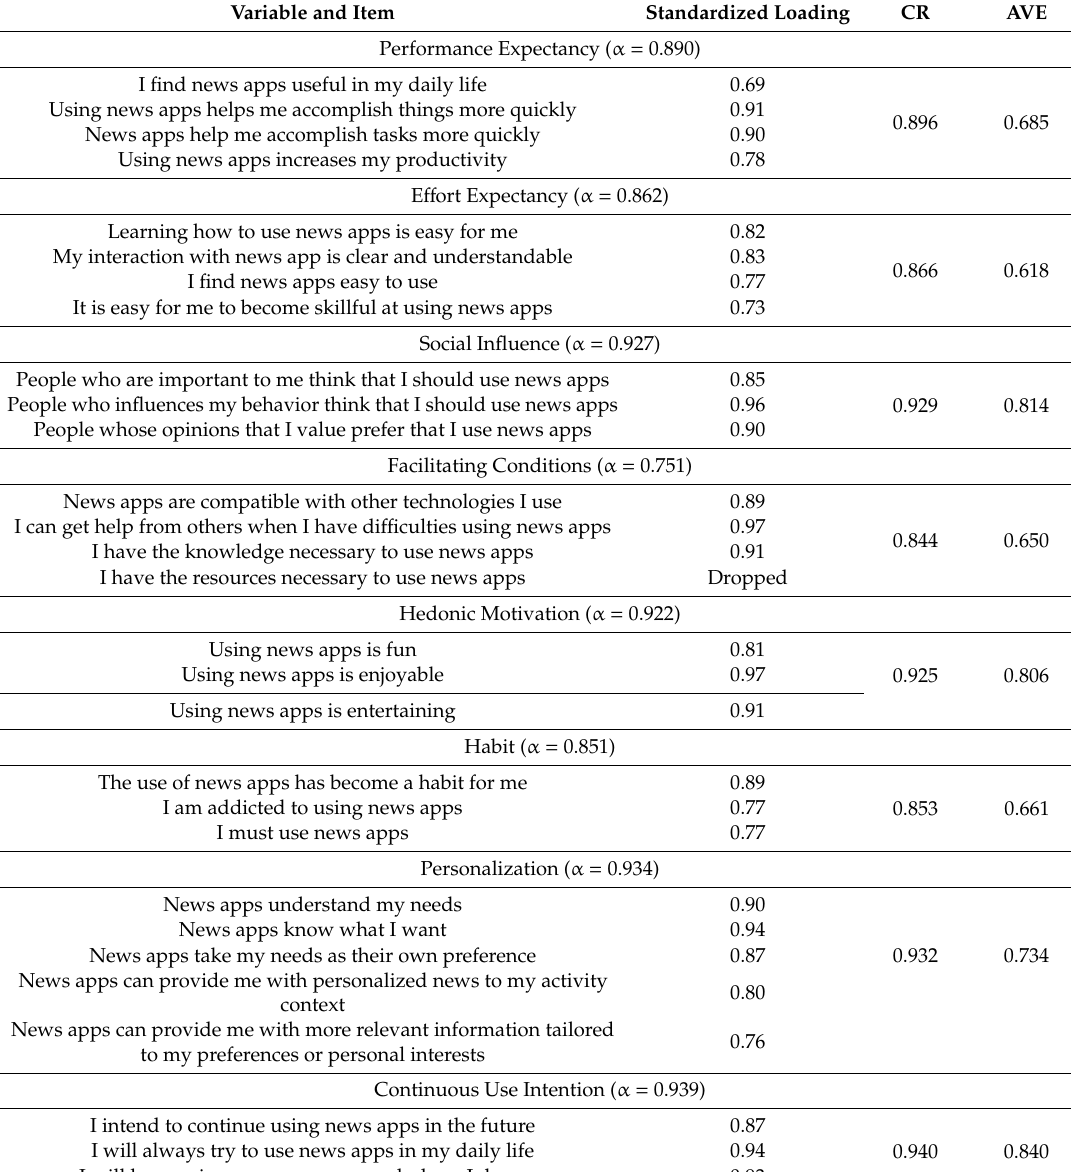
Table 2. Standardized loadings and reliability